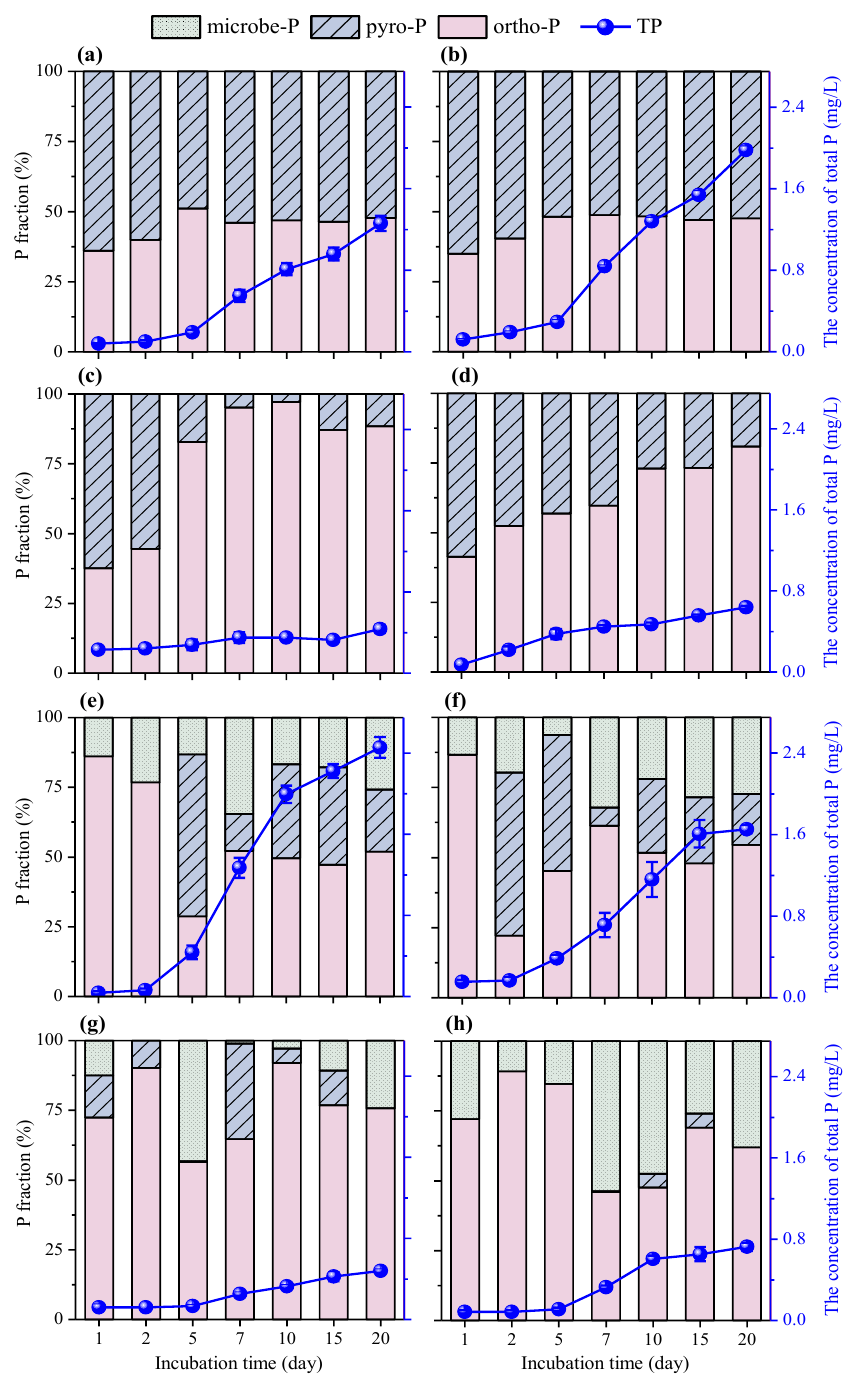
Figure 3. The concentrations of total P and different P species in the aqueous phase during 20 days’ incubation: ( a ) Fe-300, ( b ) Fe-800, ( c ) Cr + Fe-300, ( d ) Cr + Fe-800, ( e ) Fe-300 + PA, ( f ) Fe-800 + PA, ( g ) Cr + Fe-300 + PA and ( h ) Cr + Fe-800 + PA.